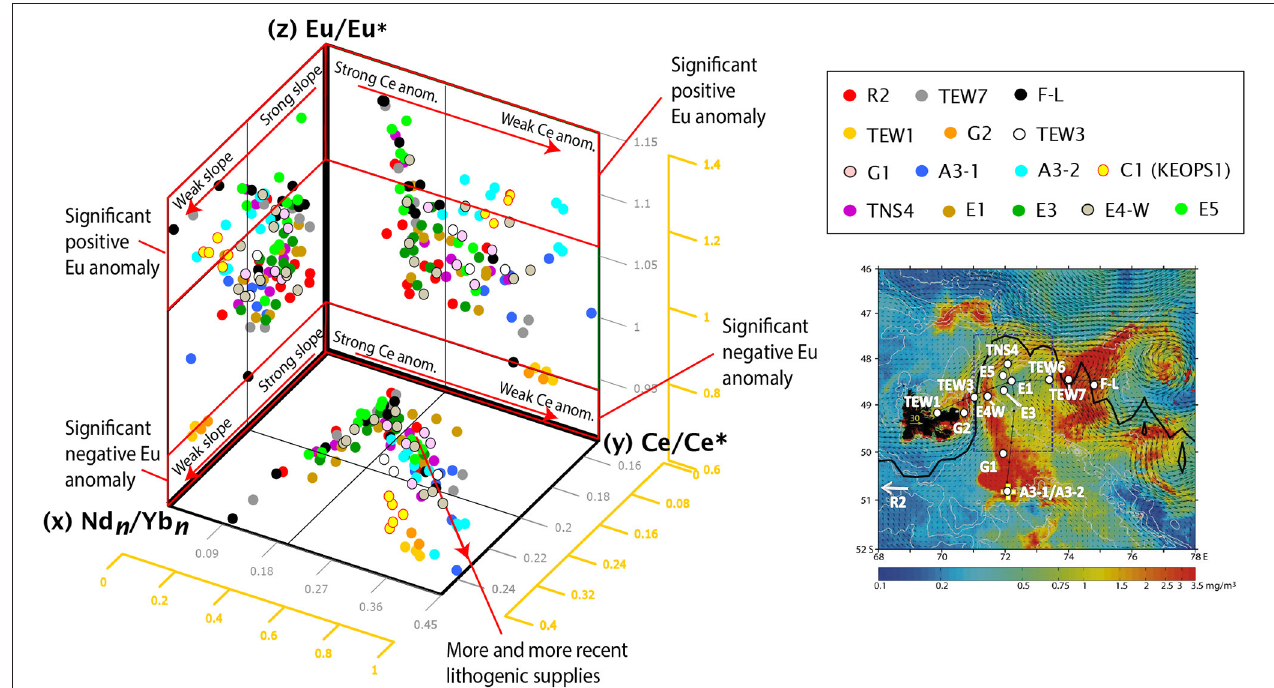
FIGURE 6 | Inter-comparisons of REE fractionations appearing to best inform about the freshness and the nature of the lithogenic supplies. xy plan: Nd n /Yb n = f(Ce/Ce*); xz plan: Nd n /Yb n = f(Eu/Eu*); yz plan: Ce/Ce* = f(Eu/Eu*). The station C1 samples from Zhang et al. (2008; KEOPS1), which characterize the Heard Island coastal waters, are also reported here, for comparison (yellow dots circled in red). Note the larger scale associated with the fractionation parameters of the coastal samples (stations TEW1, G2 and C1; yellow scales). The black lines in the xy plan represent the thresholds above which an imprint of lithogenic supplies is defined in the study as significant (i.e., for Ce/Ce* > 0.2 and Nd n /Yb n > 0.2), determined from the vertical profiles of Ce/Ce* and of Nd n /Yb n in Figure 5 . Eu anomalies included in the areas delimited by the red squares at the bottom and top of the plans xz and yz are considered as significantly negative (Eu/Eu* ≤ 0.95) and positive (Eu/Eu* ≥ 1.05), respectively (corresponding to the thresholds 1 ± 0.5, 0.5 being the average of the standard errors determined by propagation of uncertainty on the Eu/Eu* equation for each